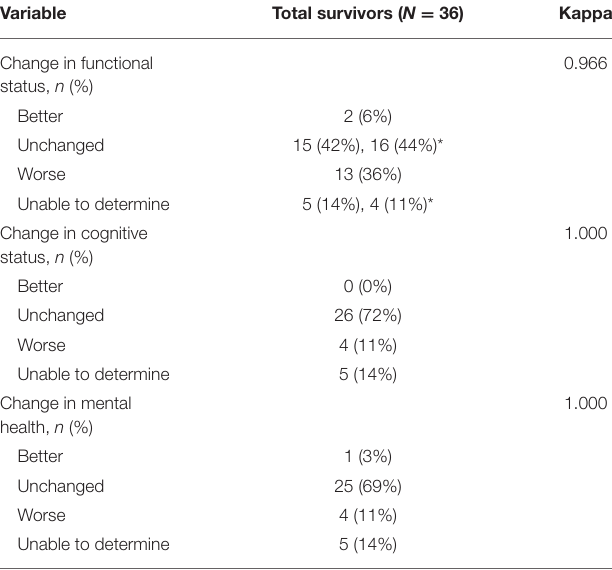
TABLE 2 | Change in pre- and post-ICU functional status, cognition, and mental health, per EHR review with corresponding agreement between two independent